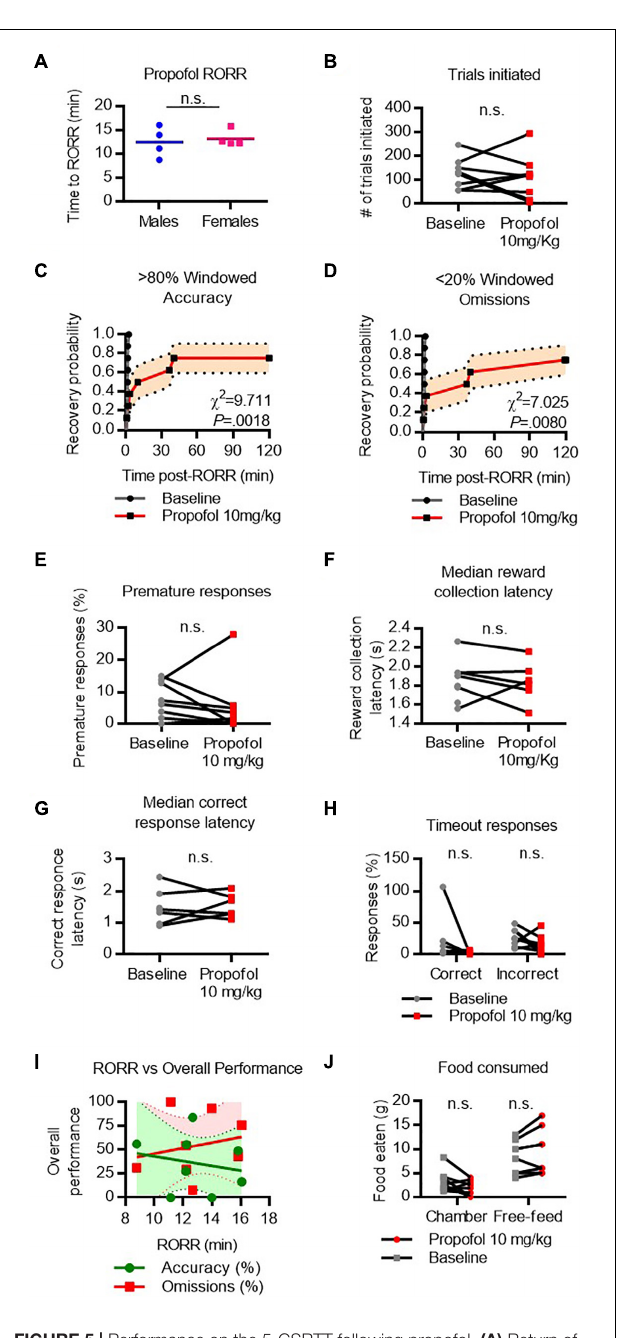
FIGURE 5 | Performance on the 5-CSRTT following propofol. (A) Return of righting reflex (RORR) following a bolus dose of 10 mg/kg propofol I.V. in male and female rats. (B) Total number of 5-CSRTT trials initiated at baseline and following propofol anesthesia. (C,D) Probability of achieving > 80% windowed accuracy (C) and < 20% windowed omissions (D) at baseline and following propofol by the indicated time. (E–H) Difference in premature responses (E) , reward collection latency (F) , correct response latency (G) , and timeout responses to correct and incorrect windows (H) at baseline and following propofol. (I) RORR latency vs. overall accuracy (green) and omission (red) performance following propofol anesthesia. Regression slope (solid line) and 95% confidence interval (dashed lines) indicated. (J) Total weight of food eaten in the chamber during the task and following the task during the free-feeding period at baseline and following propofol. n.s., not significant; N =